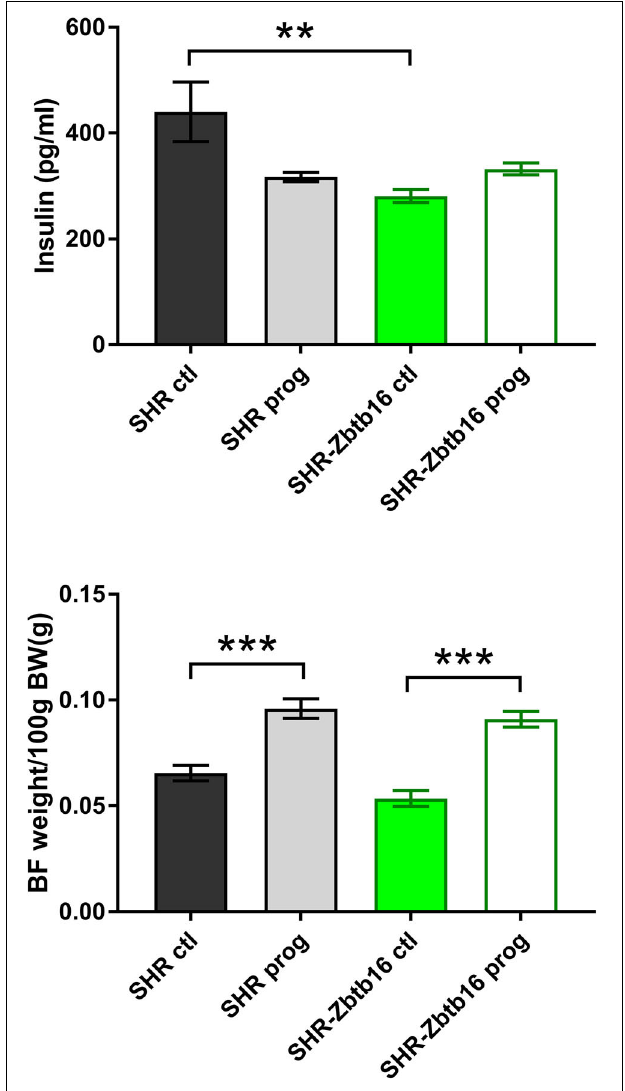
FIGURE 8 | Fasting insulin concentrations (top panel) and interscapular brown fat weight per 100g of body weight (bottom panel) in adult SHR control males (SHR ctl, black bars), SHR males programmed with maternal HSD (SHR prog, light-gray bars), SHR- Zbtb16 control males (SHR- Zbtb16 ctl, green bars) and SHR- Zbtb16 males programmed with maternal HSD (SHR- Zbtb16 prog, empty green bars). Within the graph, the significance levels of pair-wise comparisons by post-hoc Fisher’s least significant difference test of the two-way ANOVA with STRAIN and MATERNAL DIET as major factors are indicated as follows: ** p < 0.01, *** p <